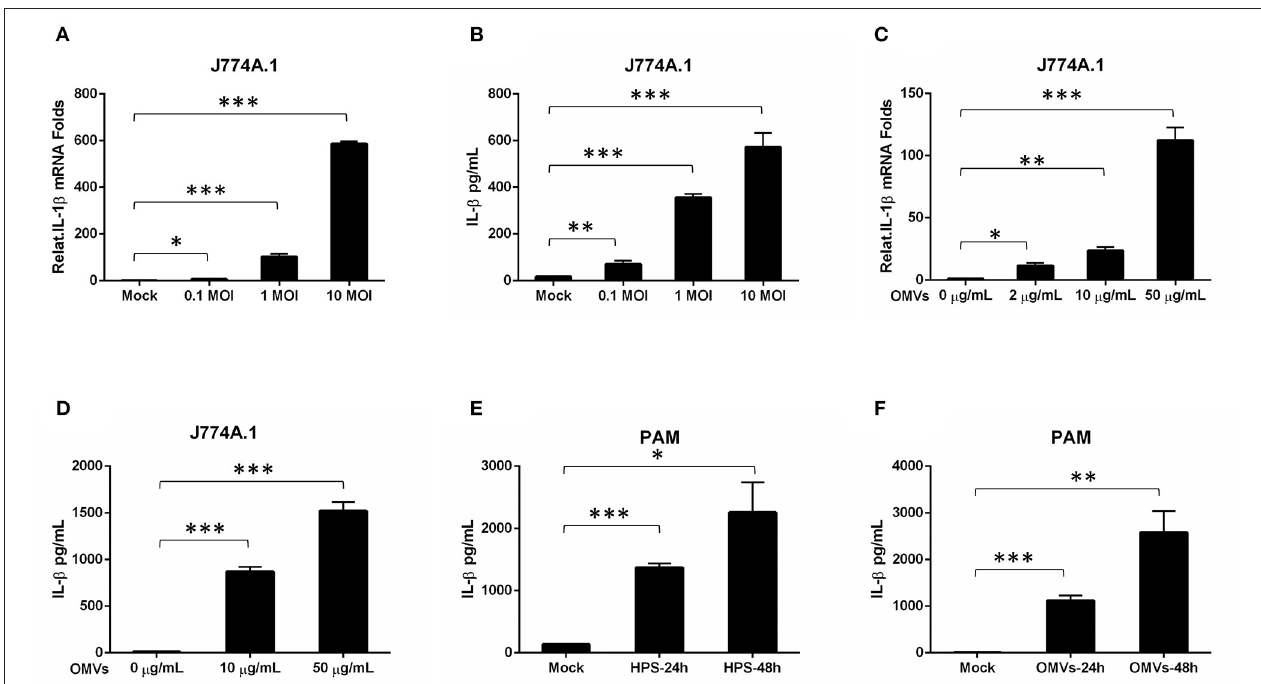
FIGURE 4 | OMV is sufficient to stimulate an inflammatory response in macrophage cells. (A,B) Mouse Mononuclear macrophage cells (J774A.1) were either mock-infected or infected with H. parasuis at different doses (0.1, 1, 10 MOI) for 24h. The mRNA levels of IL-1 β in the H. parasuis infected cells were analyzed by qRT-PCR (A) . The IL-1 β levels in the cell supernatants were analyzed by ELISA (B) . (C) J774A.1 were either mock-stimulated or stimulated with OMVs at 2 µ g/mL, 10 µ g/mL, 50 µ g/mL for 24h. The mRNA levels of IL-1 β in the cell supernatants were analyzed by qRT-PCR. (D) J774A.1 were either mock-stimulated or stimulated with OMVs at 10 µ g/mL, 50 µ g/mL for 24h. The IL-1 β levels in the cell supernatants were analyzed by ELISA. (E) PAMs were either mock-infected or infected with H. parasuis at 10 MOI for different times (24h, 48h). The I L-1 β levels in the cell supernatants were analyzed by ELISA. (F) PAMs were either mock-stimulated or stimulated with 10 µ g/mL OMVs at different times (24h, 48h). The IL-1 β levels in the cell supernatants were analyzed by ELISA. * p < 0.05, ** p < 0.01, *** p < 0.001, Student t test, in comparison groups during statistical